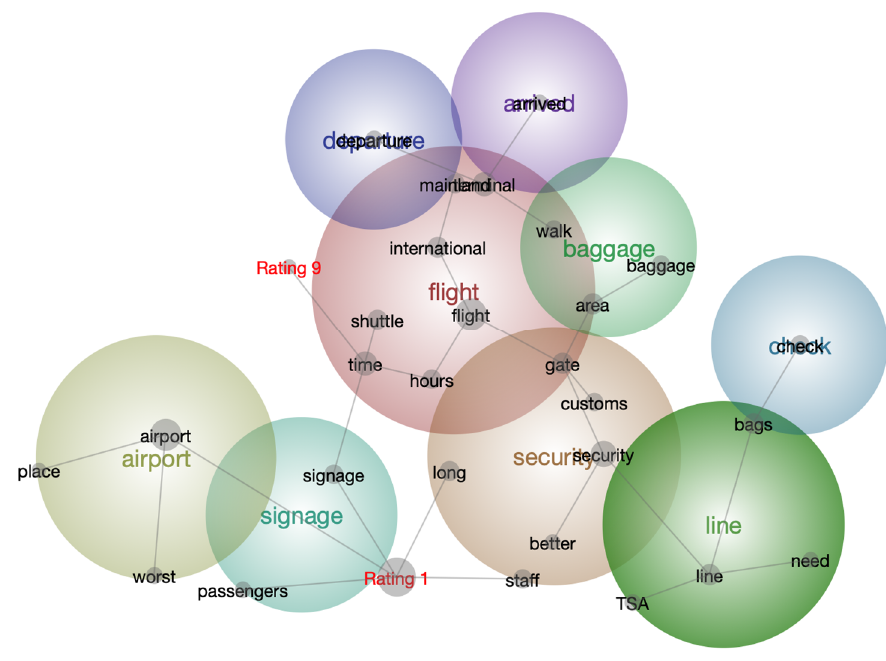
Figure 1. Concept Maps and Overall Ratings for the Honolulu International Airport.